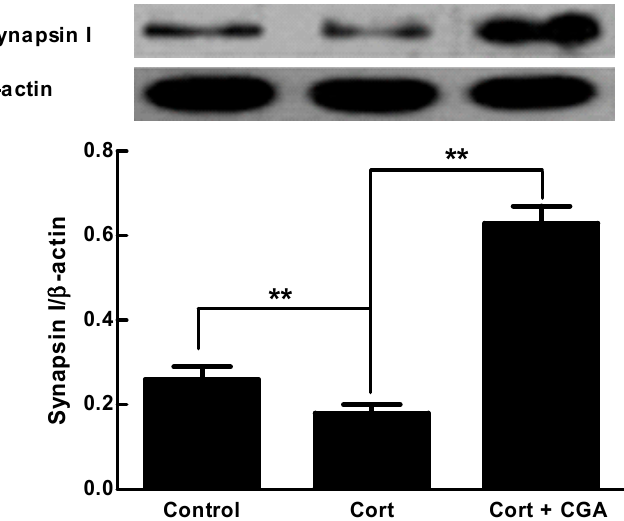
Figure 4. CGA up-regulates protein expression of synapsin I in the cells of fetal rat raphe neurons treated with Cort by western blotting. The cells were treated with culture medium with 0.1% DMSO (control), or 10 µM Cort, or 10 µM Cort + 1 nM CGA. Beta-actin was used as the loading control. The band intensities were quantified by densitometric analysis. The results are representative of at least three independent experiments run in triplicate and expressed as the mean ± SD. ** p < 0.01 vs. Cort-treated group.